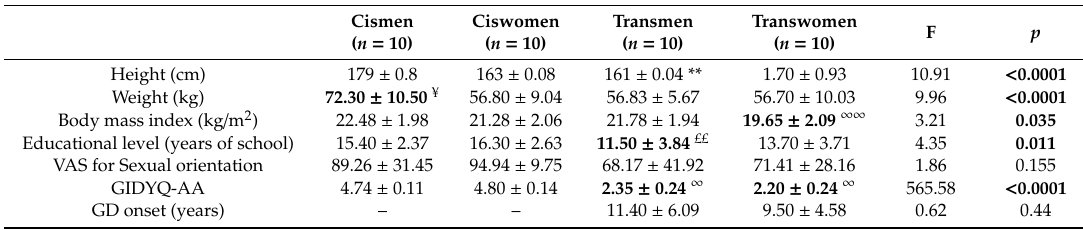
Table 1. Summary of means, standard deviations and statistical differences of the main sociodemographic characteristics between cismen, ciswomen, transmen and transwomen as derived by analysis of covariance (ANCOVA) and Post hoc Tukey’s B test after adjustment for age.